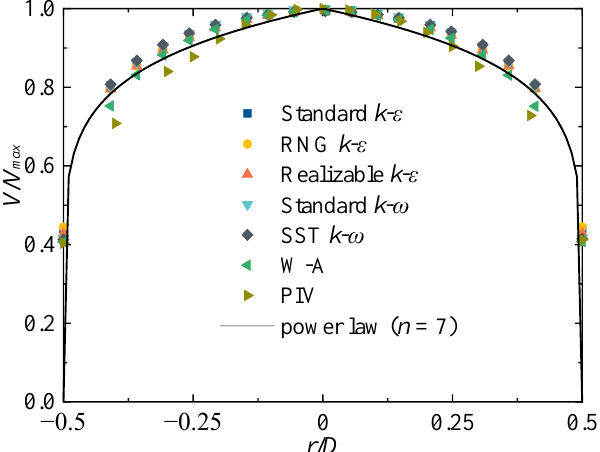
Figure 3. Comparison of axial velocity profiles of jet exit